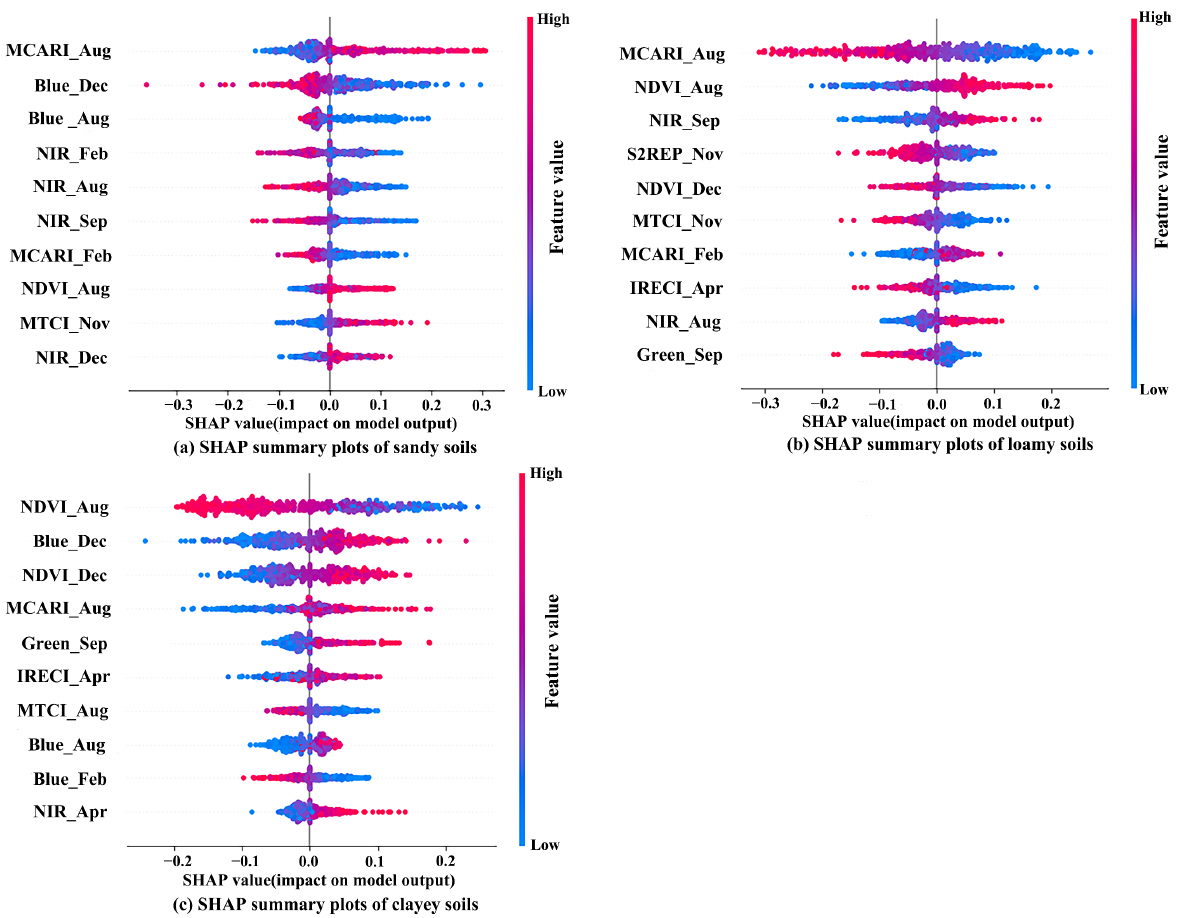
Figure 10. SHAP summary plots of top ten variables for ( a ) sandy soils, ( b ) loamy soils, and ( c ) clayey soils (each dot represents a soil instance from test data. The gradient color of the dots reflects the variable’s value changing from low (blue) to high (red). The input variables are placed along the y -axis based on their importance, and the most influential variables are kept at the top. The SHAP value reflected by the x -axis denotes the probability of being predicted as the target’s textural class. The higher the SHAP value, the higher the